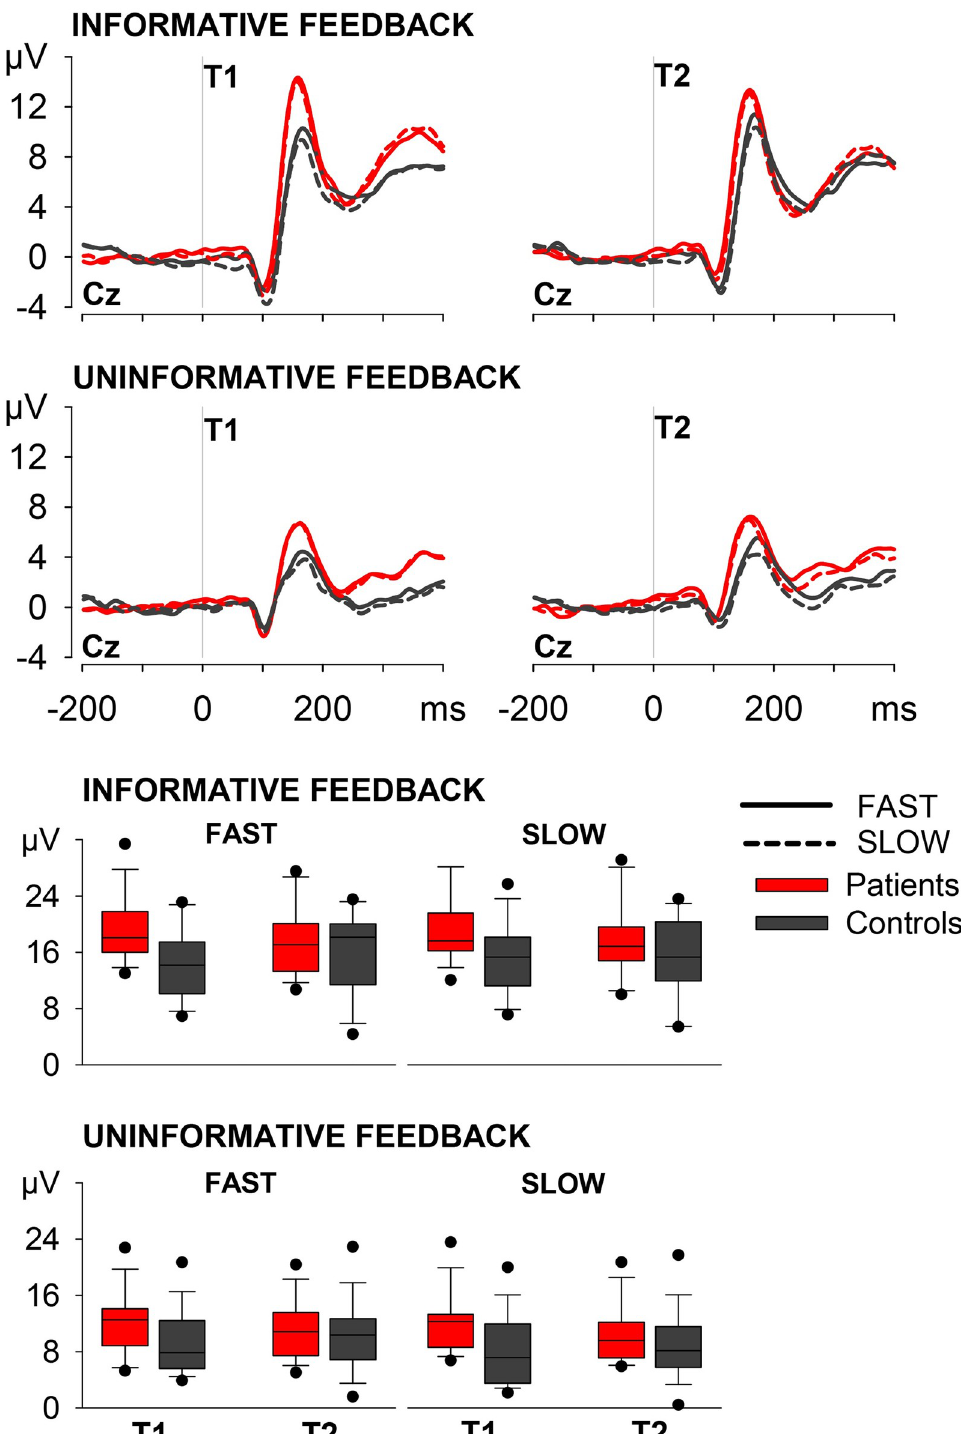
Fig 1. Feedback-locked ERPs. Grand average ERPs at Cz for trials with correct-fast and correct-slow responses in patients and controls. Box plots of the median VPP in the two groups at T1 and T2, separately for the two feedback